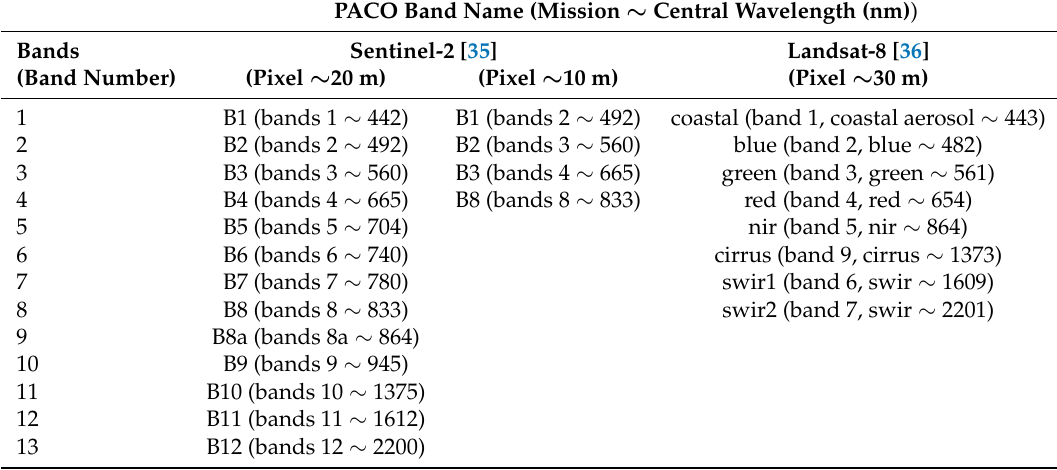
Table 2. BOA reflectance bands for Sentinel-2 and Landsat-8. The band name given by PACO is listed together with the mission original name and the proximate central wavelength (between